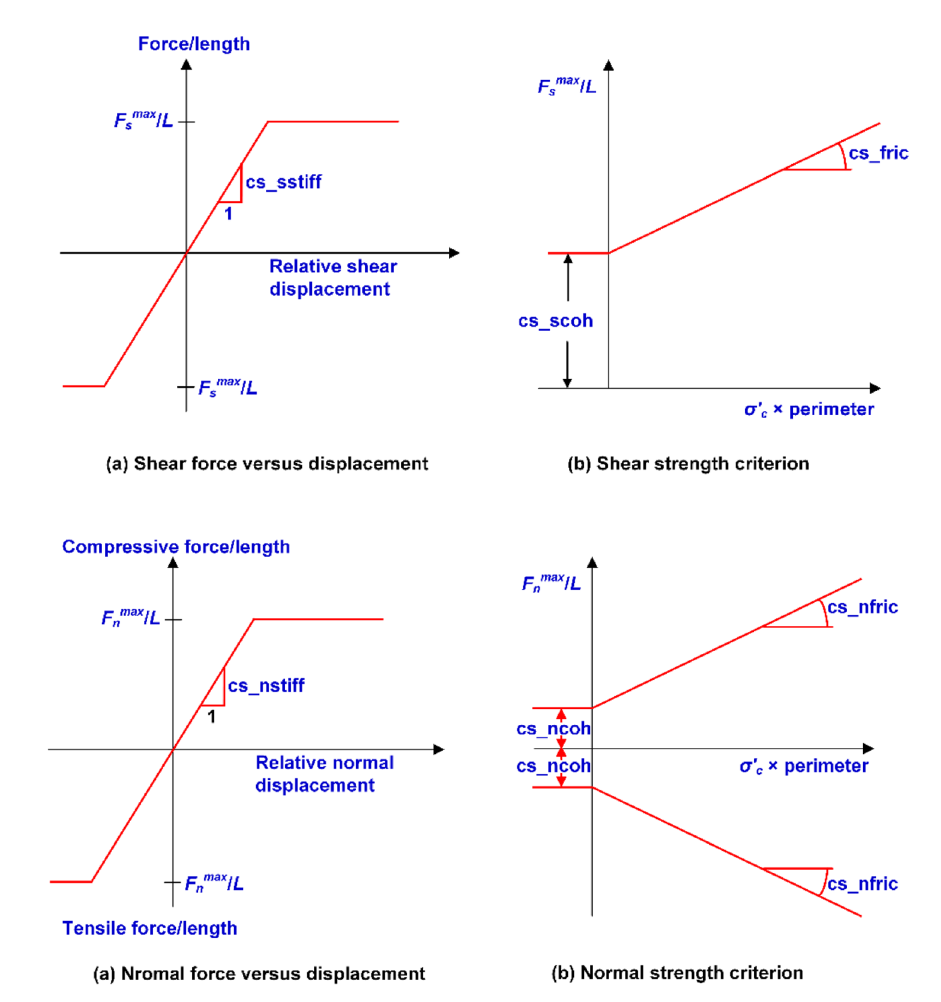
Fig. 9 Mechanical behavior